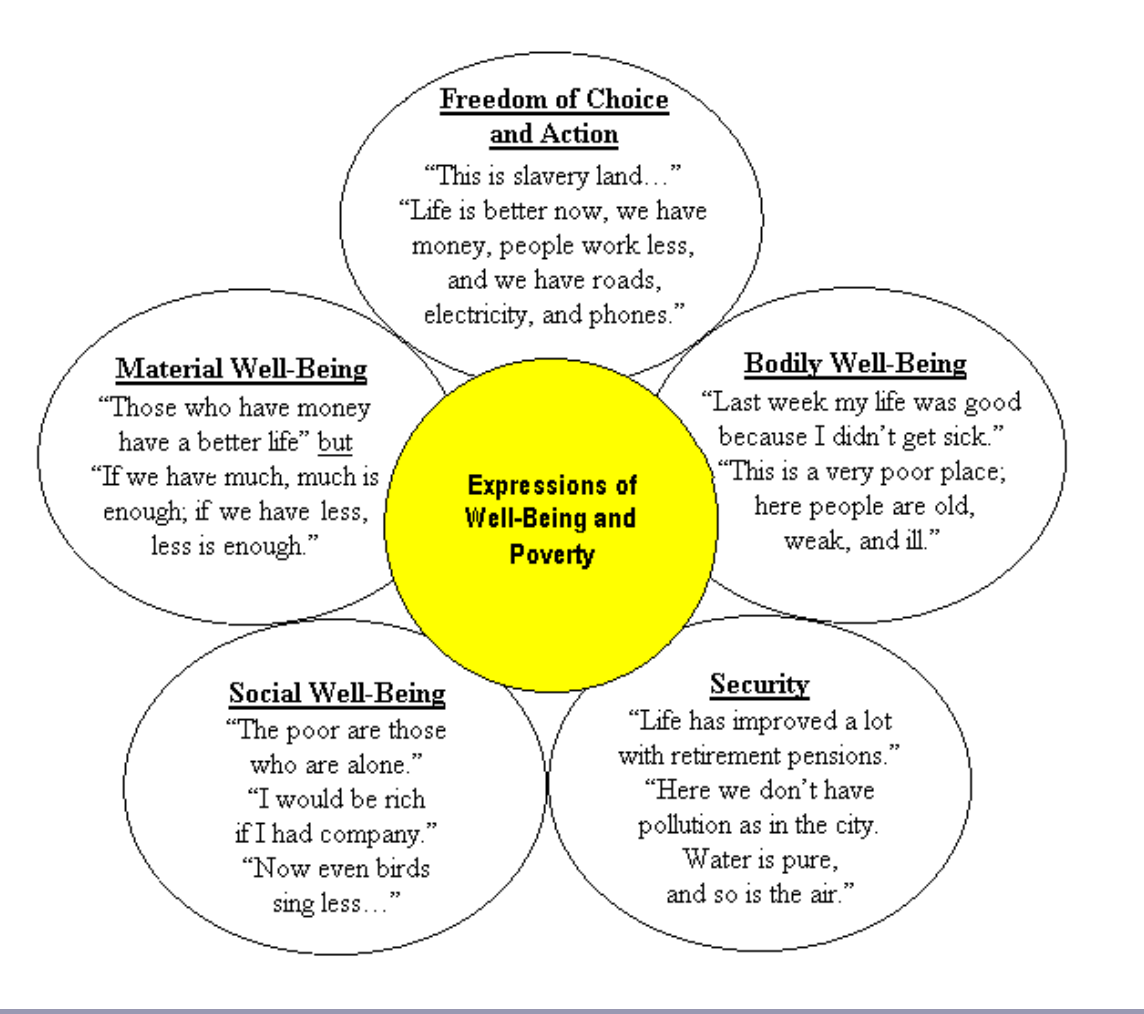
Fig. 6 . Expressions of well-being and poverty used by the residents of